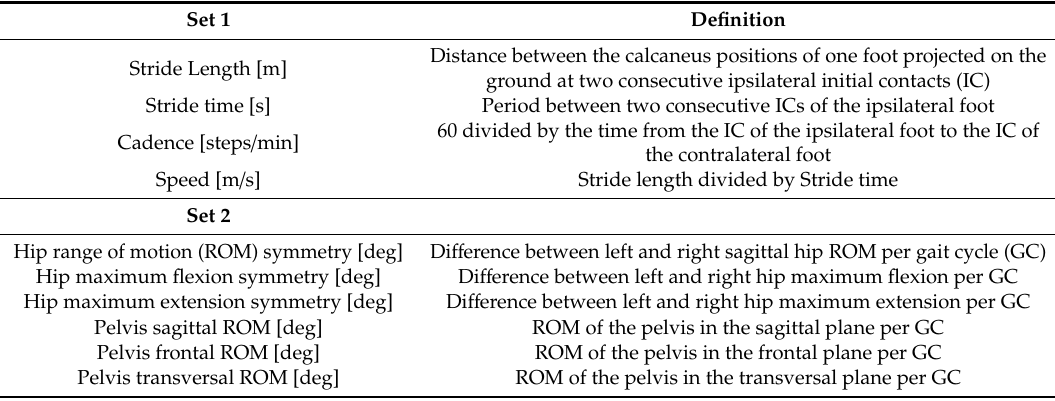
Table 1. Description of the two feature sets used for training the support vector machine (SVM)